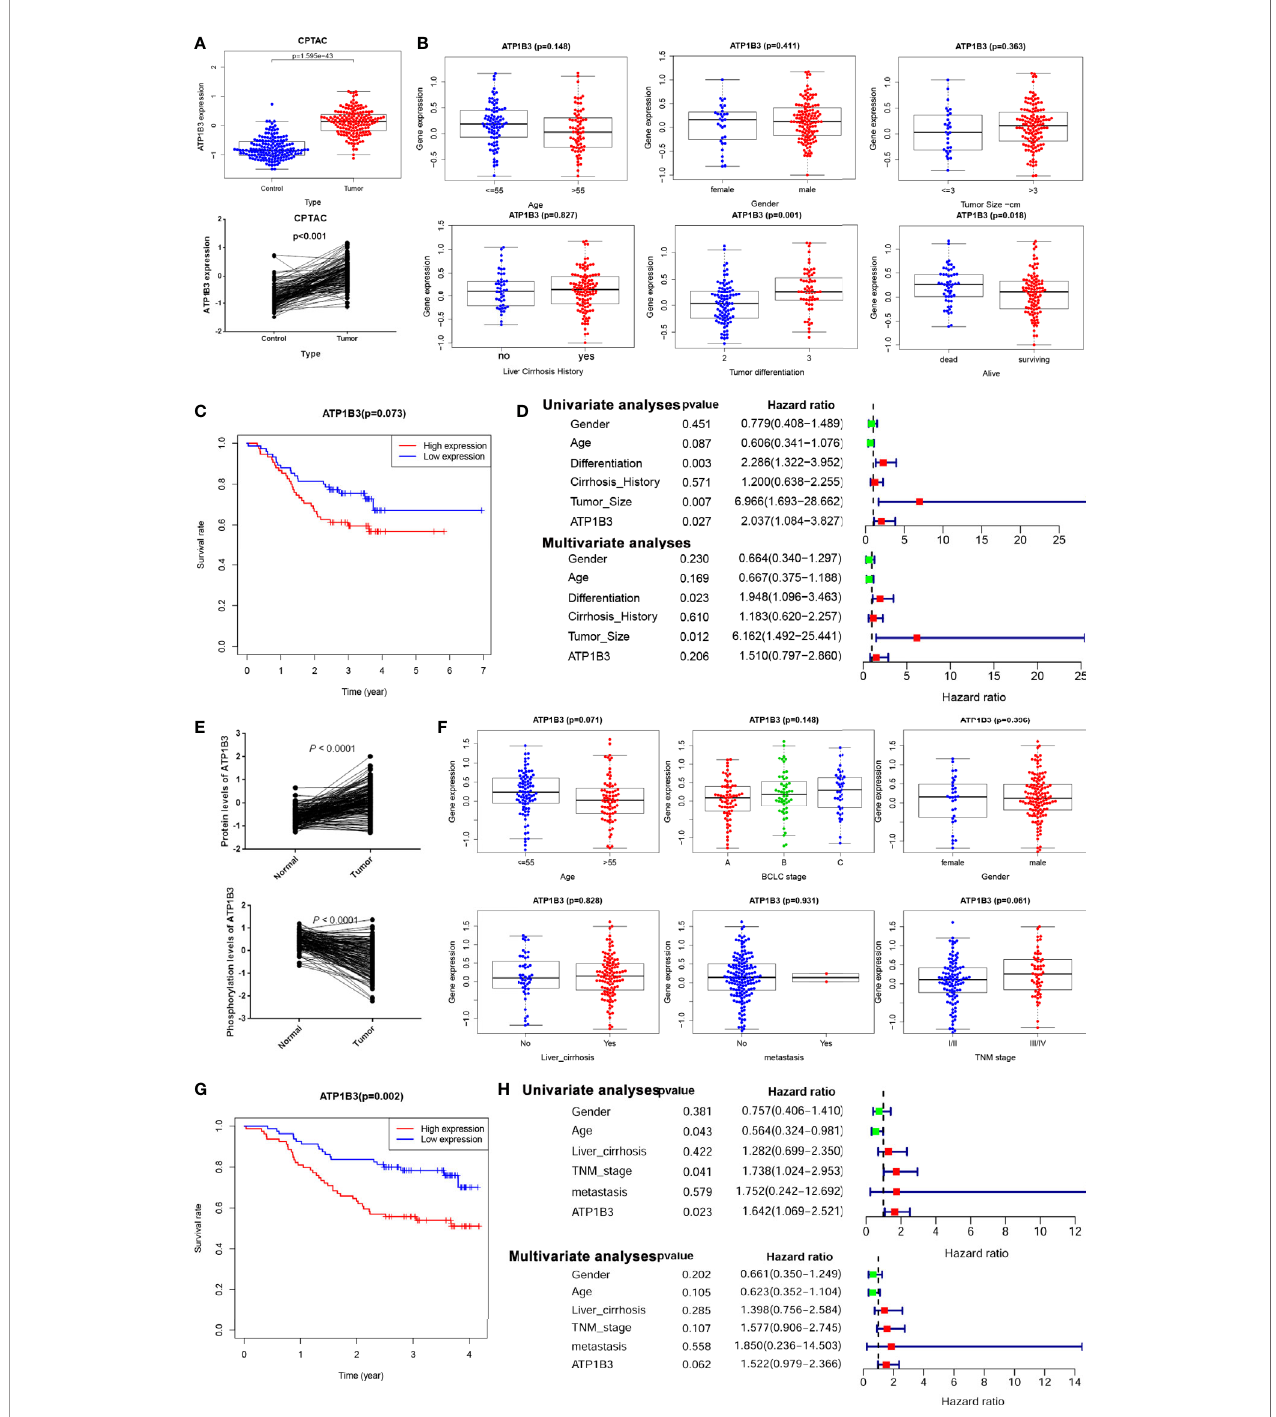
FIGURE 7 | ATP1B3 protein expression and prognosis in HCC. (A) ATP1B3 protein levels in HCC using CPTAC proteomics database. (B) The association between ATP1B3 protein expression and clinical features in HCC using CPTAC proteomics database. (C) The survival curves of OS with high/low ATP1B3 in CPTAC HCC cohorts. (D) Univariate and multivariate analysis revealed the relationship between ATP1B3 and the clinical factors with OS of HCC in the CPTAC database. (E) The protein level and the phosphorylation level of ATP1B3 in the proteomics and phosphor-proteomics data. (F) The association between ATP1B3 protein expression and clinical features in the proteomics and phosphor-proteomics data. (G) The survival curves of OS with high/low ATP1B3 in the proteomics and phosphor- proteomics data. (H) Univariate and multivariate analysis revealed the relationship between ATP1B3 and the clinical factors with OS of HCC in the proteomics and phosphor-proteomics